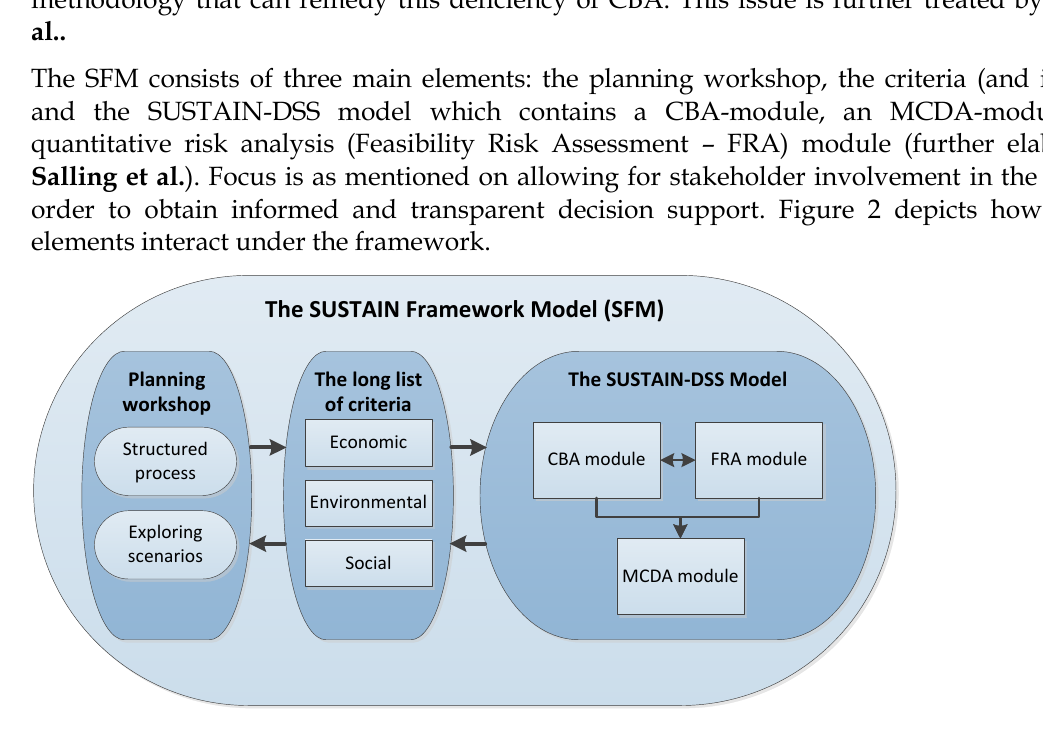
Figure 2. The SUSTAIN Framework Model indicated by its main